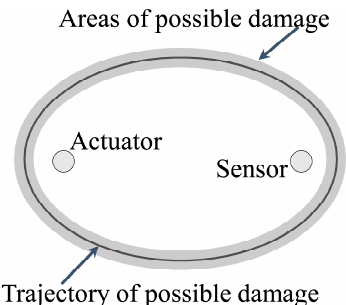
Figure 4. Probability imaging algorithm.